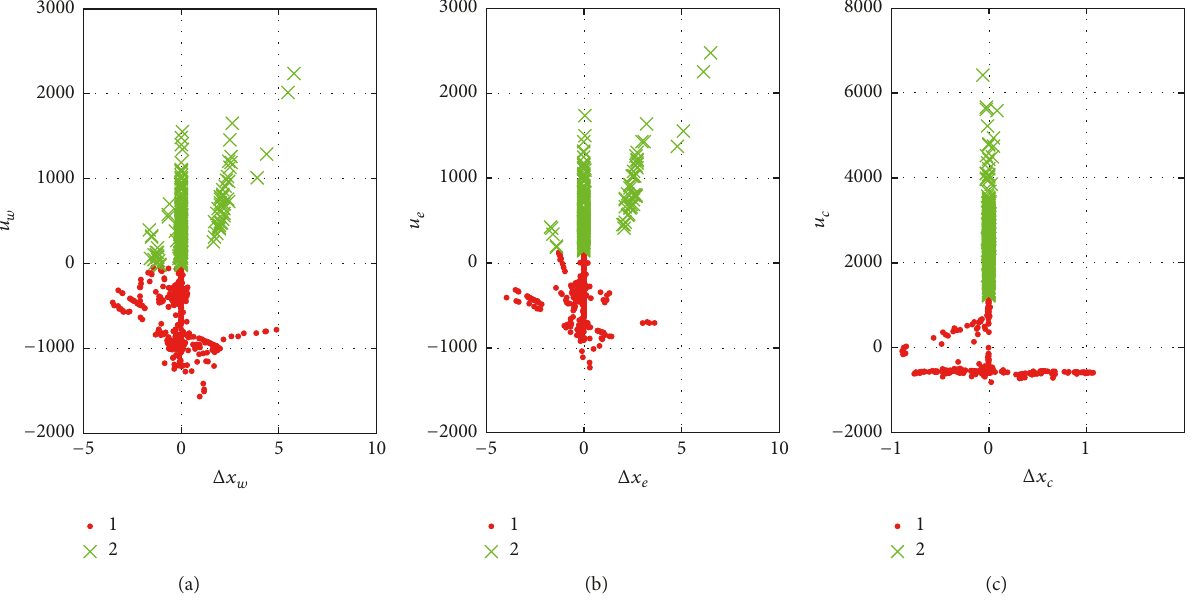
Figure 17: 𝐾 -means clustering of the (a) west zone, (b) east zone, and (c) core